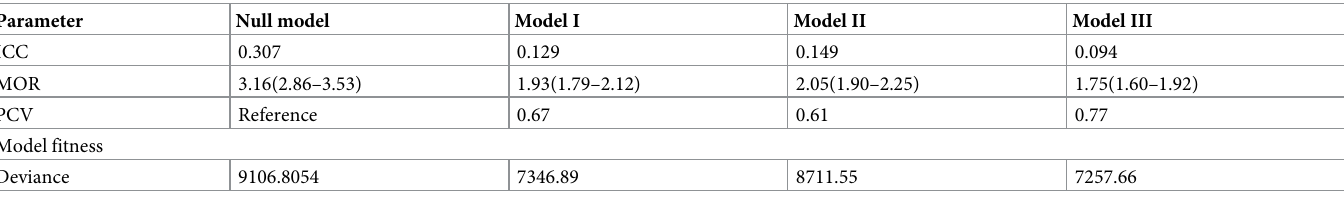
Table 2. Random effect model and model fitness for determinants of births protected against neonatal tetanus.